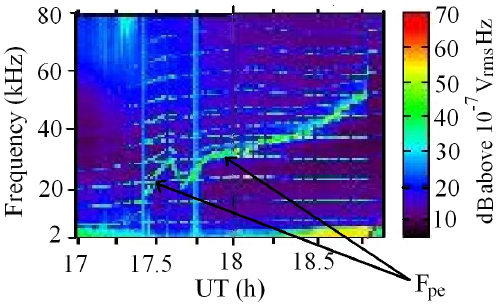
Figure 2. Frequency–time spectrogram measured by the WHIS- PER instrument onboard C3 between 17:00 and 18:50UT on 3 June 2004. The plasma frequency ( F pe ) is indicated by the black arrows.